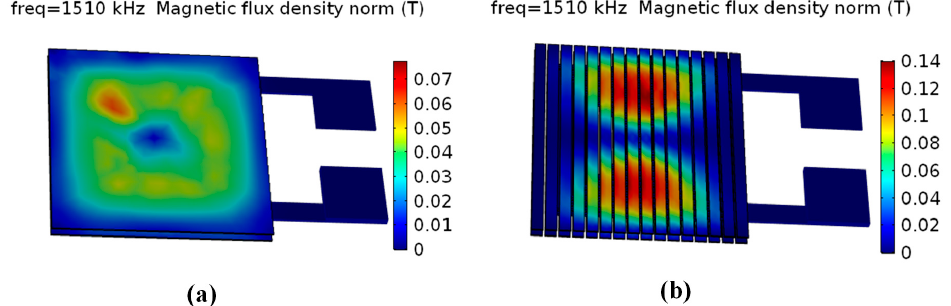
Figure 4. Distribution of surface magnetic flux density of micro-inductor. ( a ) Non-patterned magnetic film; ( b ) patterned magnetic film.